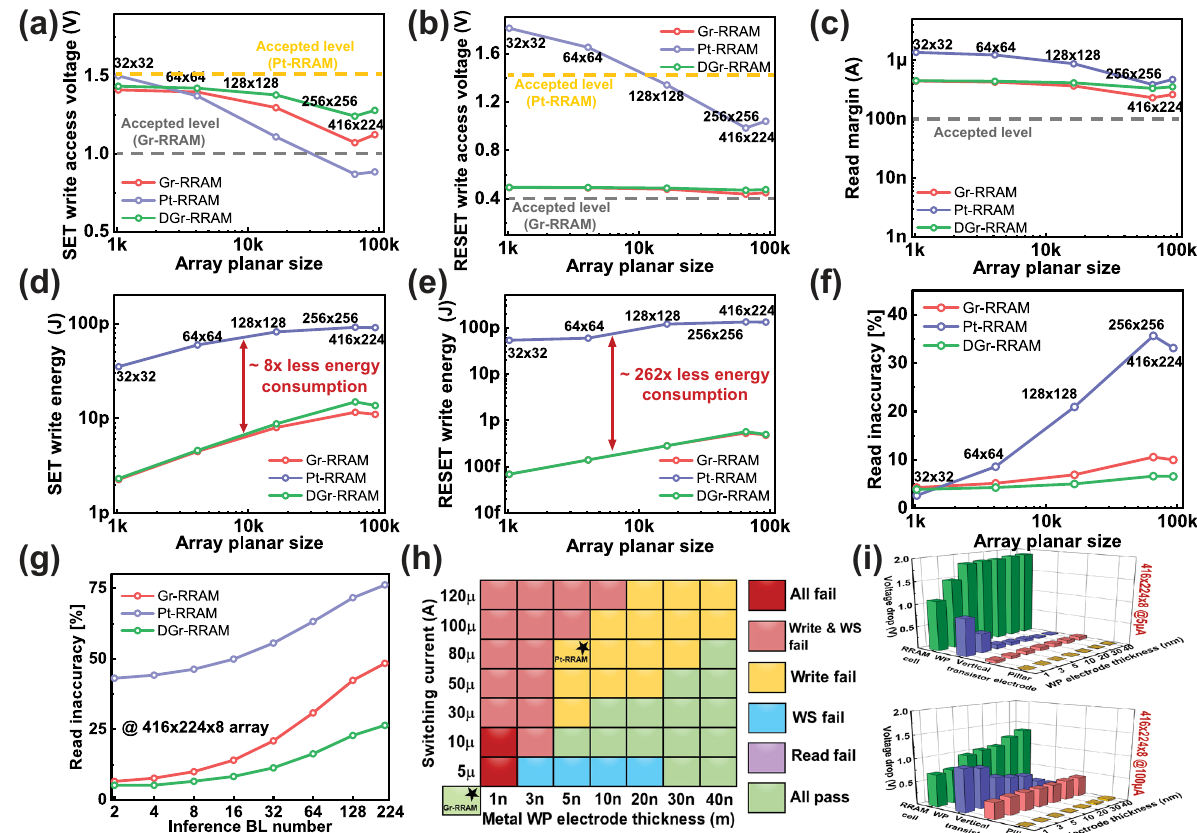
Fig. 5 Comparison of the Pt-, Gr-, and DGr-RRAM performances in 3D structure with 8-layers at the various planar array sizes. a, b Write access voltage for a SET and b RESET processes. c Read margin at V R = 0.1 V where the minimum current difference is required to exceed 100 nA to distinguish HRS and LRS states. d , e Array programming energy consumption in d SET and e RESET operations. f Read inaccuracy during the WS operation at the worst-case weight pattern. g Read inaccuracy as a function of multiple BLs reading, which is important for parallel inference computing for the 416 × 224 × 8 VRRAM array size, necessary for MNIST data recognition. h Shmoo plot with different switching currents ( I W ) and metal WP electrode thicknesses, including the special case of Gr-RRAM. i Comparison of write voltage drop change as a function of WP thickness on various circuit components at I W = 5 μ A (top) and 100 μ A the circuit, speci fi cally the WP electrode and vertical transistors, contribute to the IR drop and sneak-path issues of the input voltage pulse. The evolutions of voltage drop over the WP and transistor as a function of the array size for all devices are shown in Supplementary Fig. 8. Due to WP interconnect resistance, limited saturation current in the vertical transistors, and 1T k R con fi gura- tion of VRRAM, high switching currents are undesirable during programming. Fortunately, the low switching currents in Gr- RRAMs can forcefully reduce the effective resistance of the array. In this study, the 416 × 224 array size is particularly signi fi cant for requirements for sense ampli fi ers to differentiate HRS and LRS